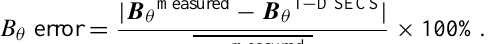
Fig. 3. Schematic equivalent currents, attained by rotating the IMAGE ground horizontal magnetic field vectors 90 ◦ clockwise and the track of CHAMP on 6 November 2001, at 05:04–05:08 UT.